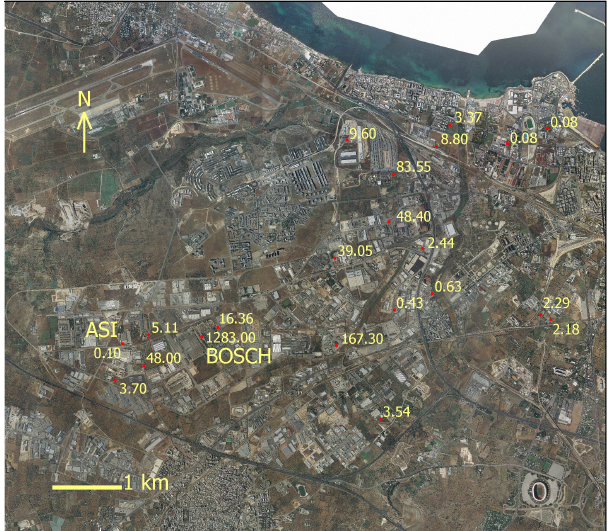
Figure 7. Location of the detected contamination by PCE (µgL − 1